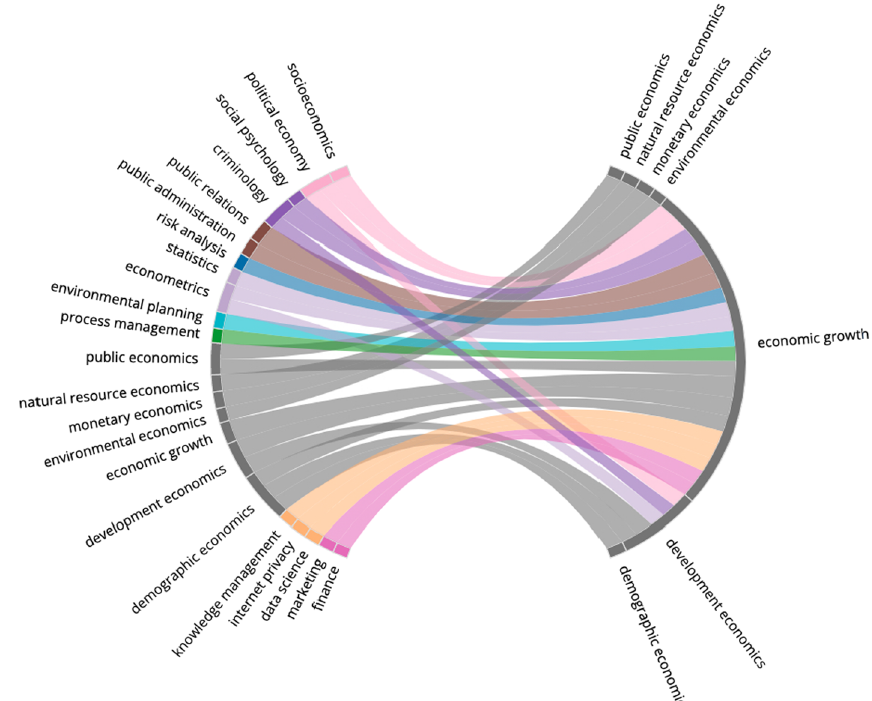
Fig. 7 Temporal FoS Network presenting COVID-19-related research in Economics, produced from 1355 COVID-related research papers which were attributed to the MAG field